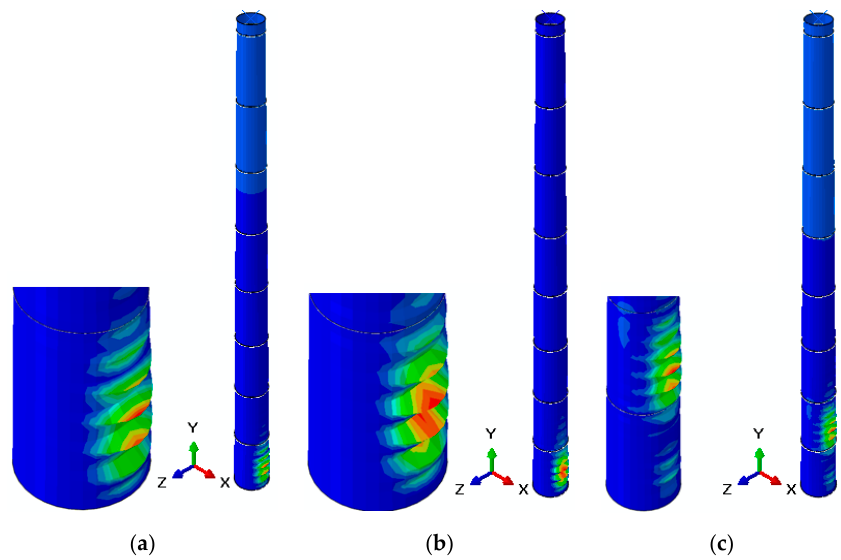
Figure 17. Buckling analysis of Tower I under horizontal force. ( a ) Mode 1, ( b ) Mode 2, ( c ) Mode 3.